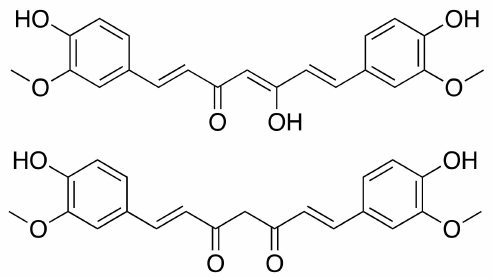
Figure 11. Curcumin in enol (top) and ketone (down)